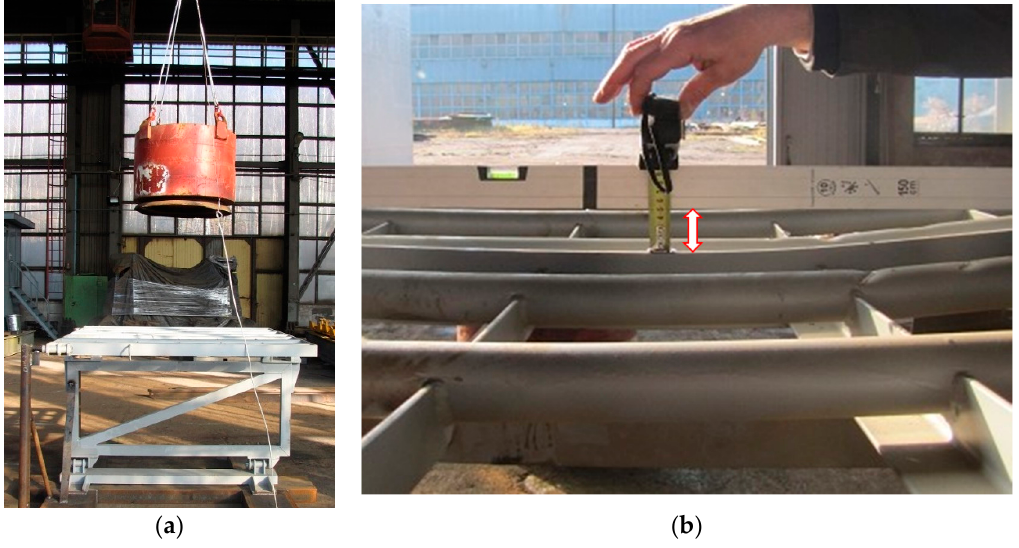
Figure 2. Destructive test preparation and results: ( a ) test impactor raised by the overhead crane above the tested shield; ( b ) measurement of the maximum plastic displacement of the front face of the shield.